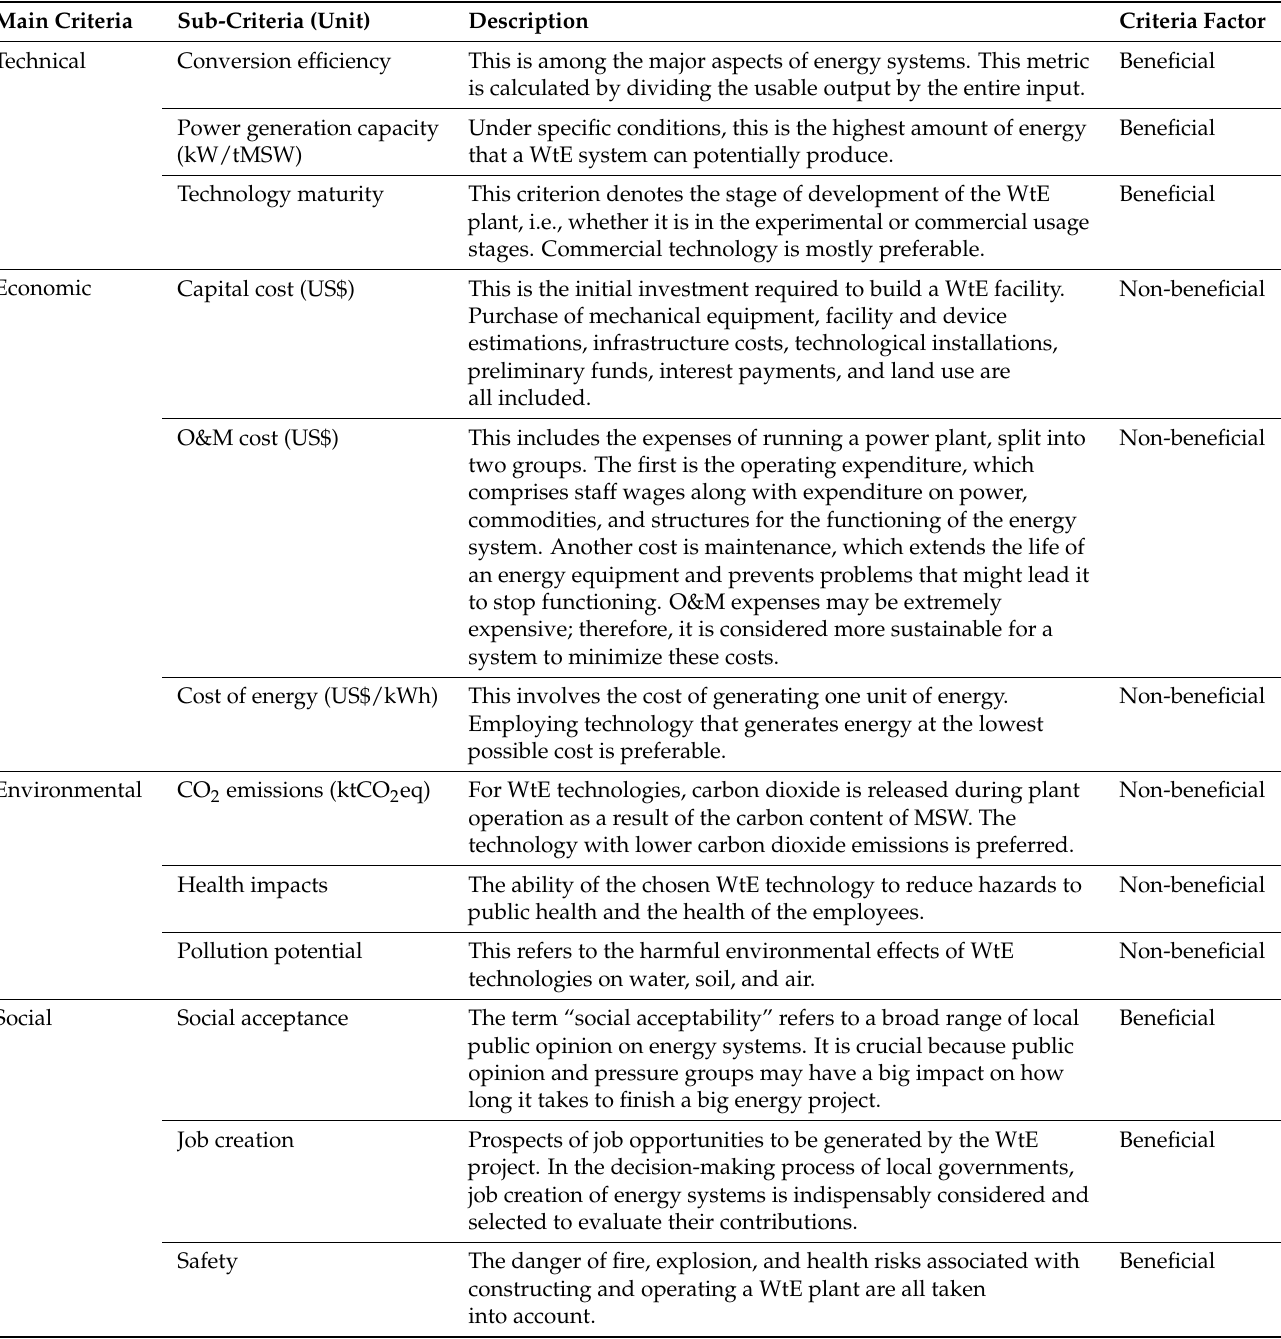
Table 3. Summary of the evaluation